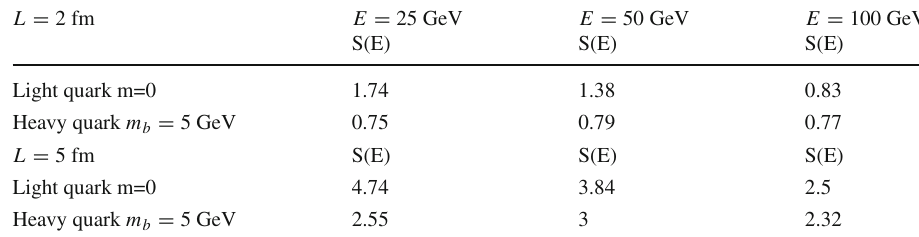
Fig. 4 The energy loss in the leading order in α s for L = 5 fm for different values of θ as a function of the radiated gluon energy ω , divided by α s C F right-total energy loss in Moller theory, left-HO approximation.We use Eq. 20 for Q Table 1 The estimate